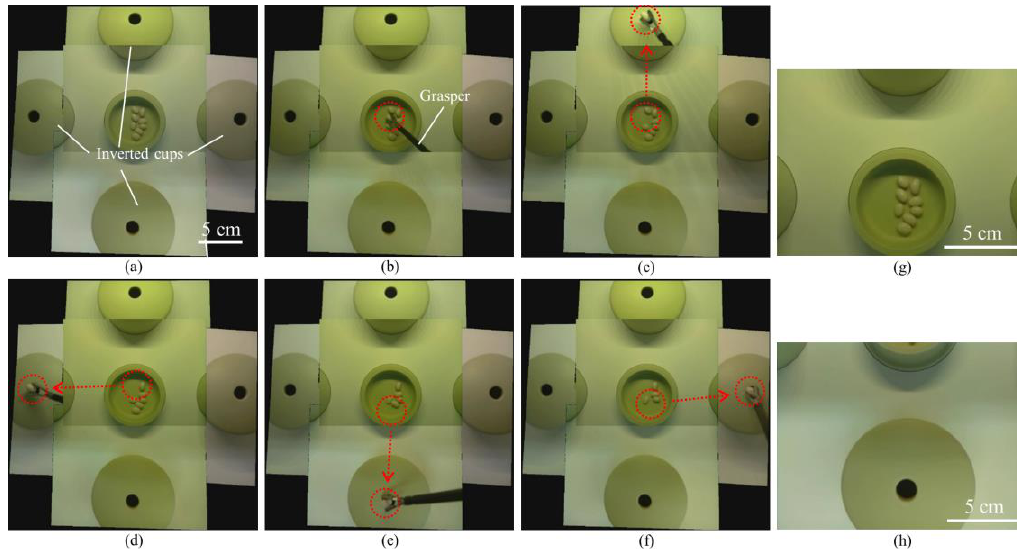
Figure 8. Captured images from a real-time stitched video during a modified bean drop task in the simulator box by using the TCA. ( a ) Setup of a modified bean drop task. ( b – f ) We successfully performed a modified bean drop task by using the real-time stitched video without any physical camera maneuver. The red dotted circles and arrows in each figure show initial and end positions and trajectories of the moving beans picked by a grasper. ( g , h ) The captured images from two single cameras show that a single camera cannot cover the saucer and the inverted cup simultaneously.